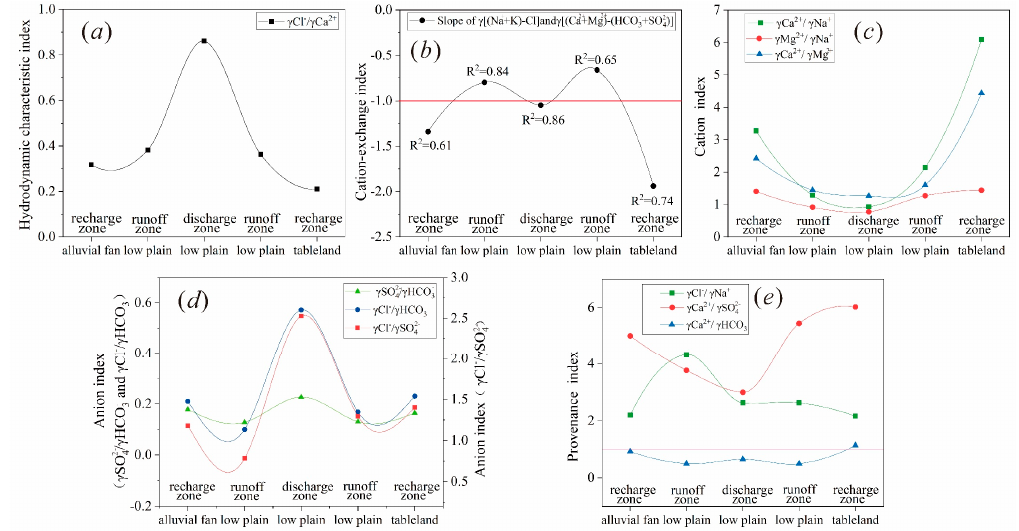
Figure 6. Quantitative index in different partitions ( a ) γ Cl − / γ Ca 2+ , ( b ) slope of γ (Na + + K + − Cl − ) and γ (Ca 2+ + Mg 2+ ) − (SO 42 − + HCO 3 ), ( c ) cation ratio coefficient, ( d ) anion ratio coefficient; ( e ) provenance